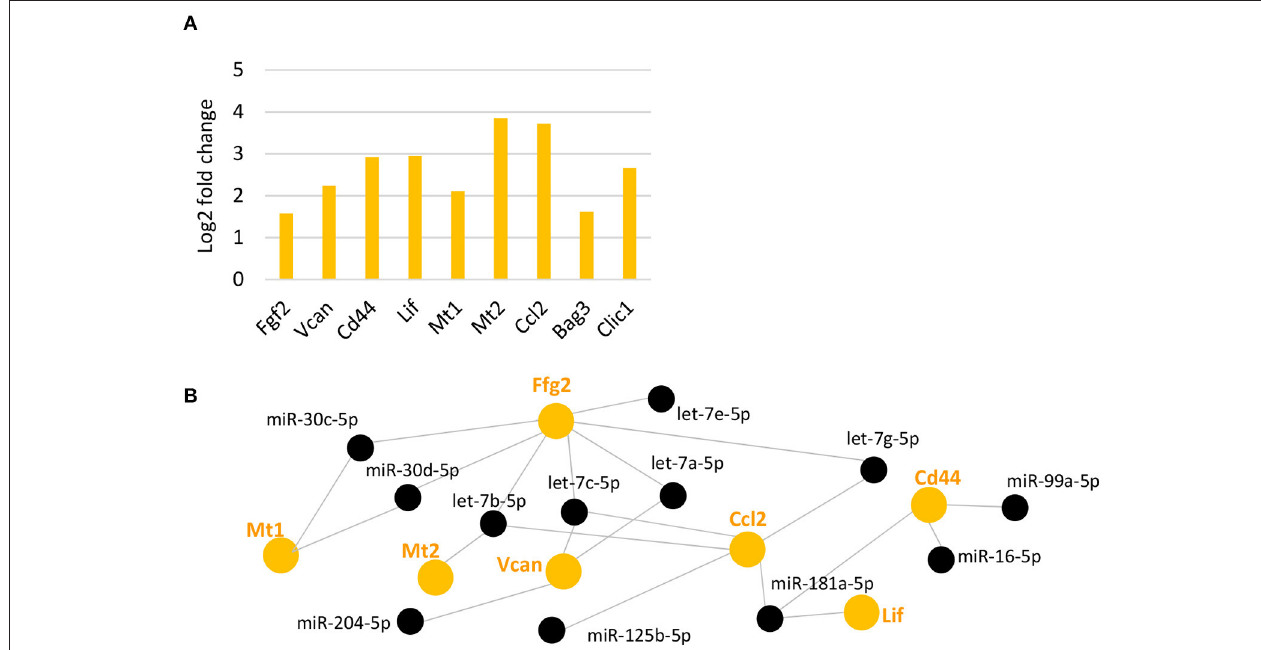
FIGURE 5 | Upregulated reported genes after light damage and their potential miRNA regulators. (A) Expression levels (fold change of log 2 relative expression) of reported genes upregulated after light damage compared to undamaged controls (five and six biological replicates, respectively, one technical replicate per condition). (B) : DIANA-TarBase analysis of genes in A and MG miRNAs that declined and are likely to target these genes based on prediction and experimental confirmation. FDR, false discovery